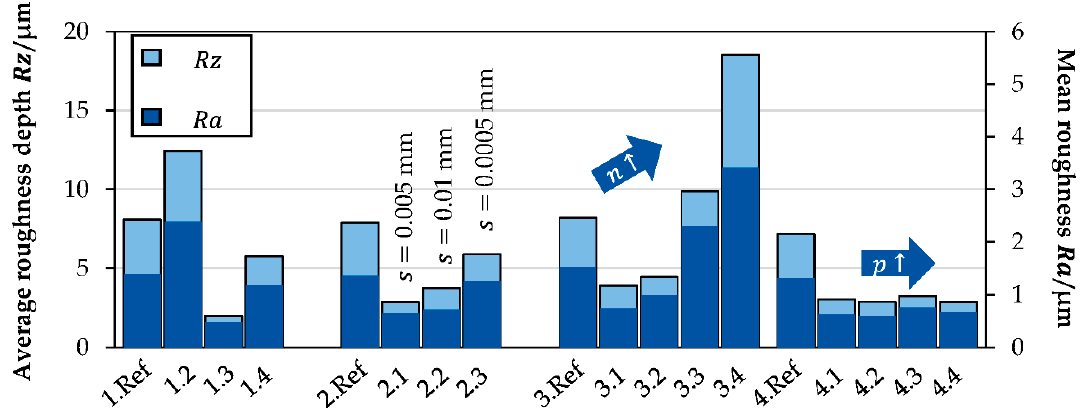
Figure 5. Roughness after machining.